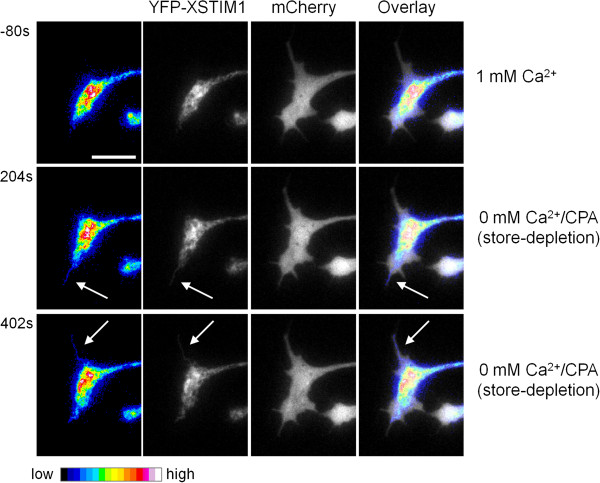
Dynamic translocation of STIM1 into neuronal filopodia in response to store-depletion. Representative time-lapse fluorescent images of growth cone expressing YFP-XSTIM1 before (1 mM Ca2+) and after store Ca2+ depletion (0 mM Ca2+/CPA). mCherry was co-expressed to mark filopodia and growth cone. Images were pseudocolored to enhance the observation of intensity changes. The arrows indicate newly translocated XSTIM1 proteins into neuronal filopodia. Scale bars: 10 μm.